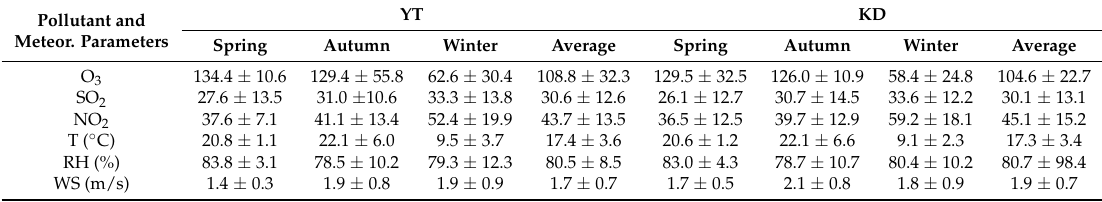
Table 1. Average concentrations of SO 2 , NO 2 , and O 3 in the atmosphere and average temperature, relative humidity, and wind speed during the sampling periods. Pollutant and meteor.